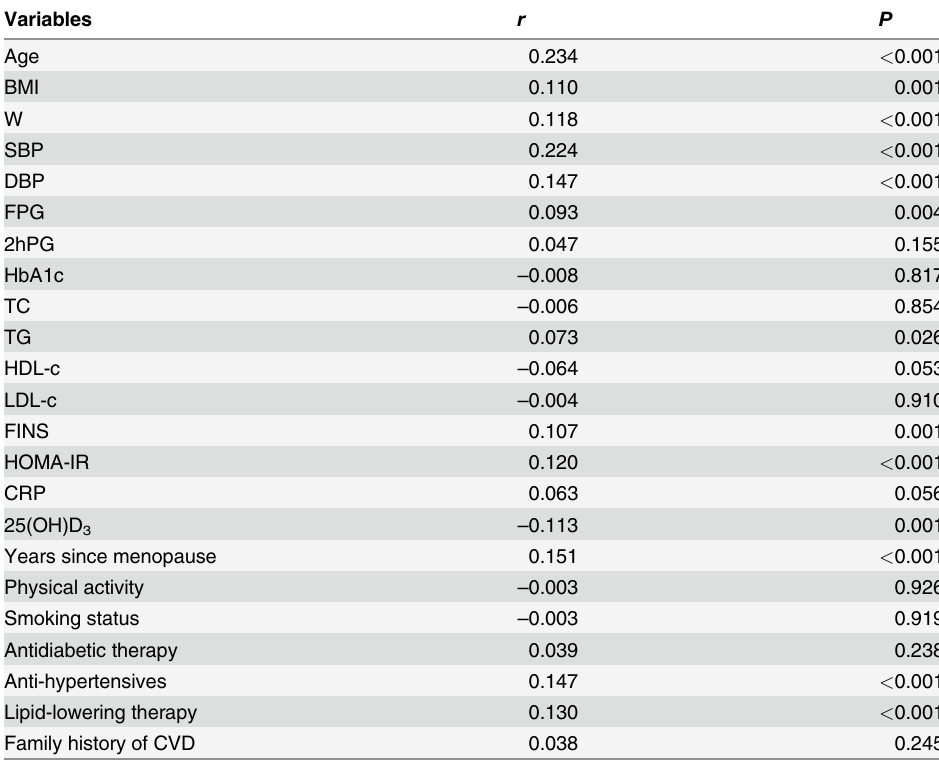
Table 2. Spearman ’ s correlation analysis between C-IMT and clinical